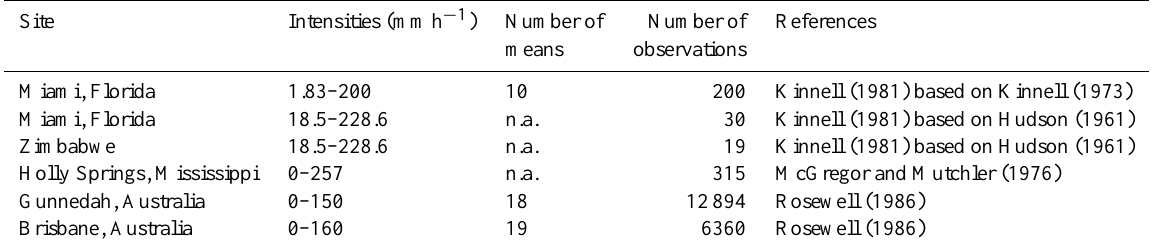
Table 2. Sources of data used for the analysis of the uncertainty associated with the Kinnell (1981)